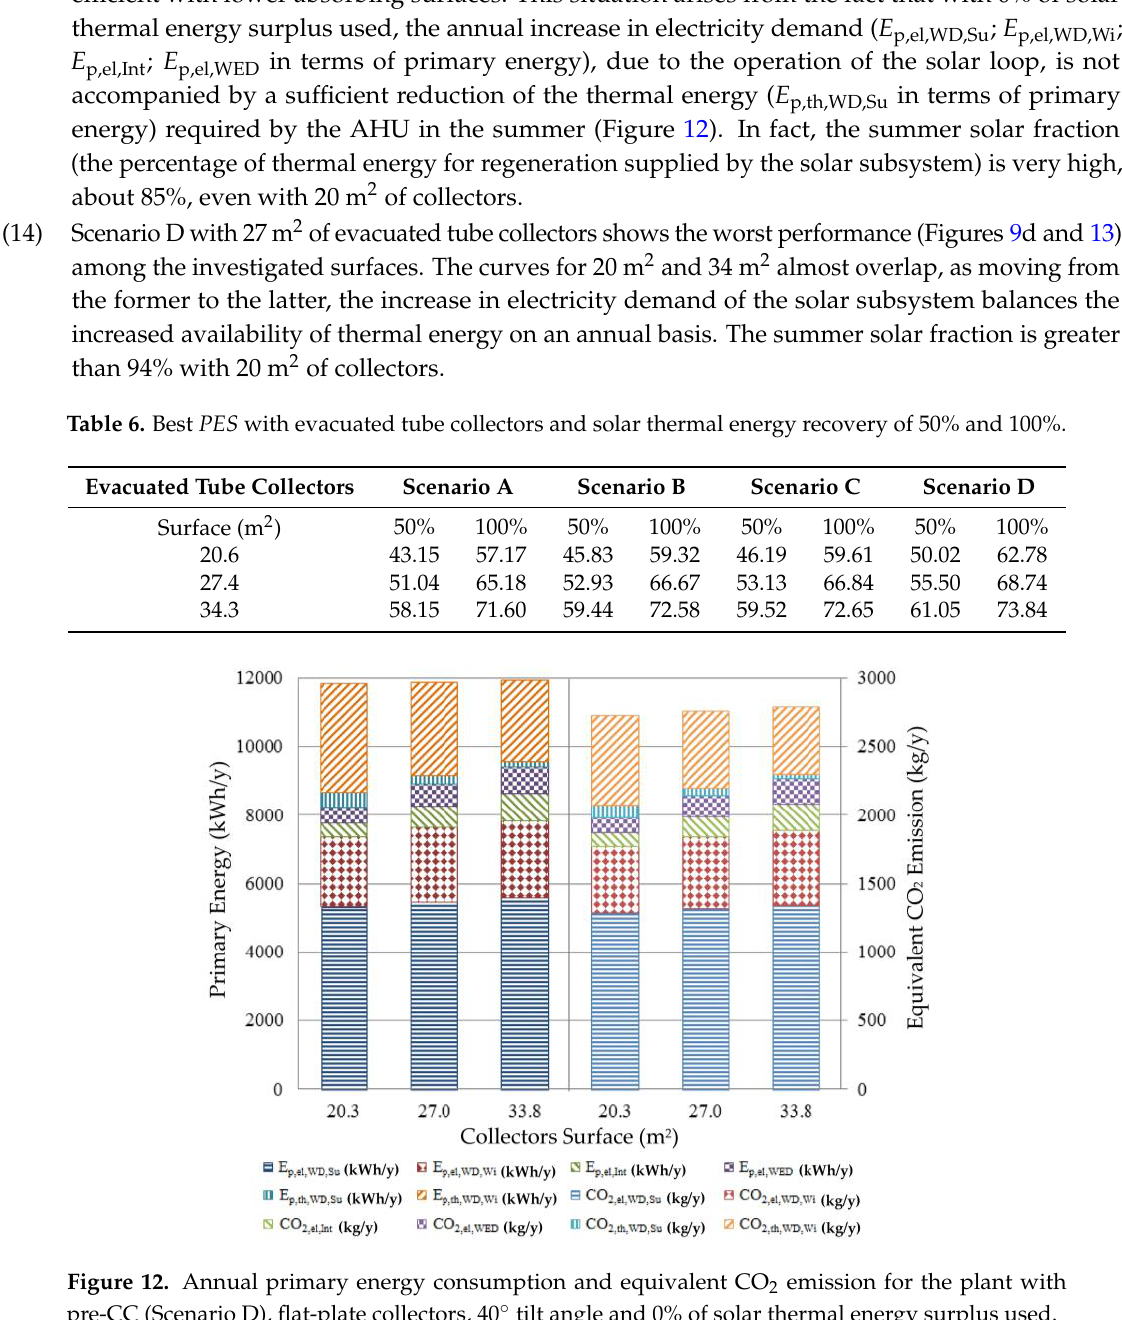
Table 6. Best PES with evacuated tube collectors and solar thermal energy recovery of 50% and 100%. Evacuated Tube Collectors